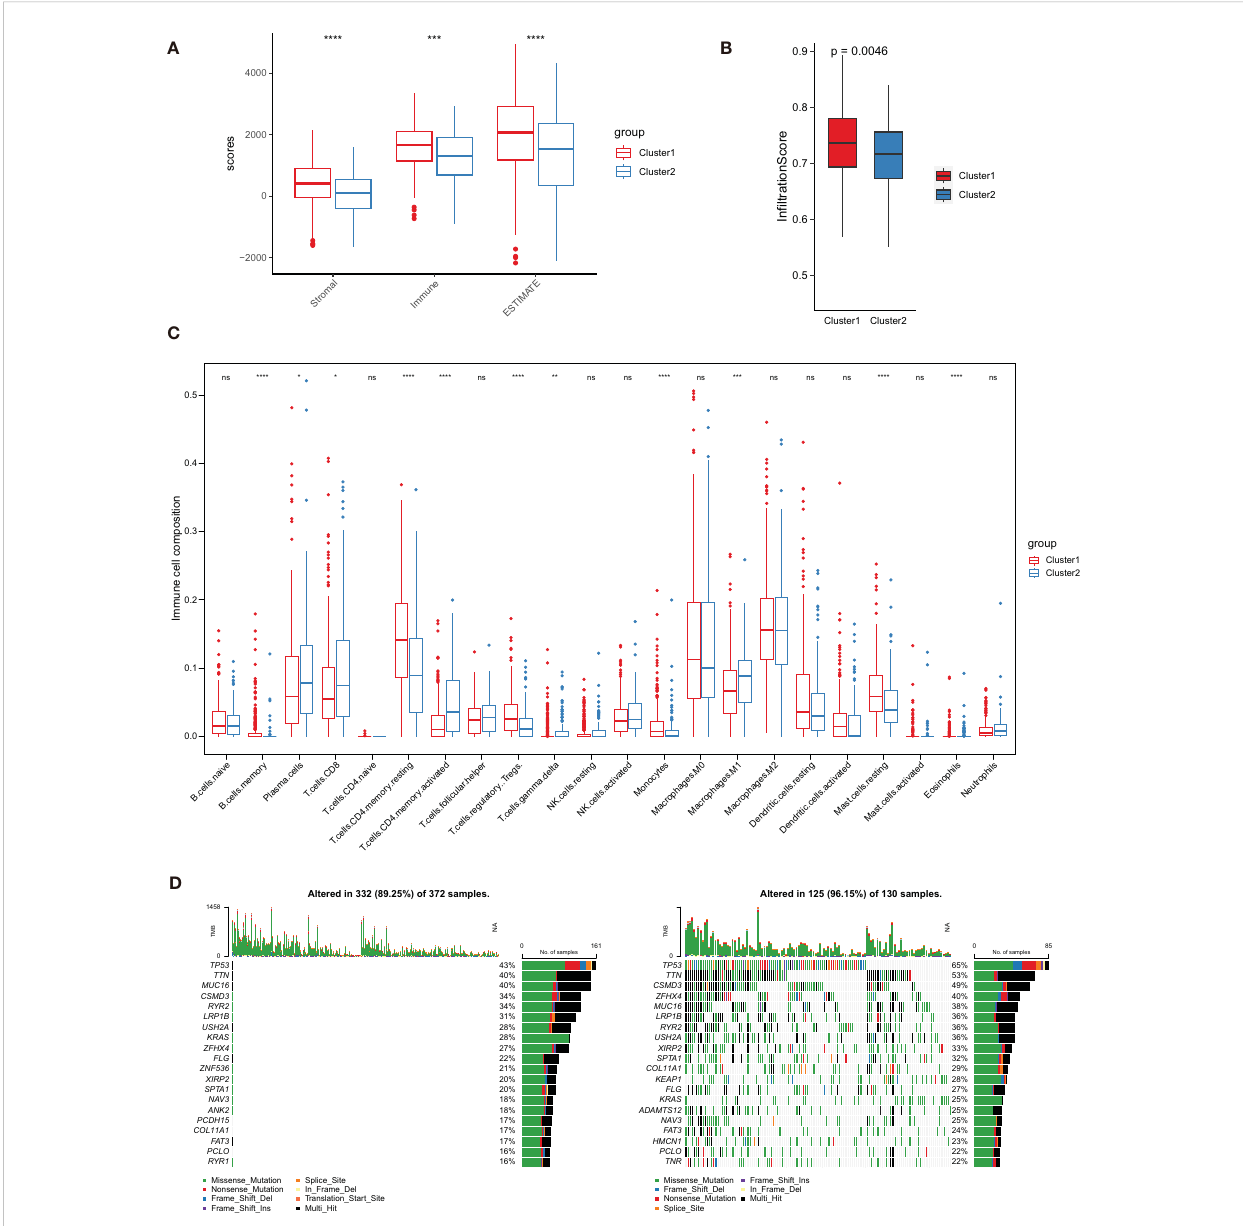
FIGURE 5 Characterization of tumor microenvironment (TME) cell in fi ltration and somatic mutation in clusters 1 and 2. (A) Analysis of differences in TME scores (including Stromal score, Immune score and ESTIMATE score). (B) Analysis of differences in In fi ltration score. (C) Boxplot shows the in fi ltration abundance of 22 immune cells obtained from CIBERSORT analysis. (D, E) Comparison of the top 20 genes with the highest somatic mutation frequency in the two clusters. ∗ P < 0.05, ∗∗ P < 0.01, ∗∗∗ P < 0.001, ∗∗∗∗ P < 0.0001 and ns represents